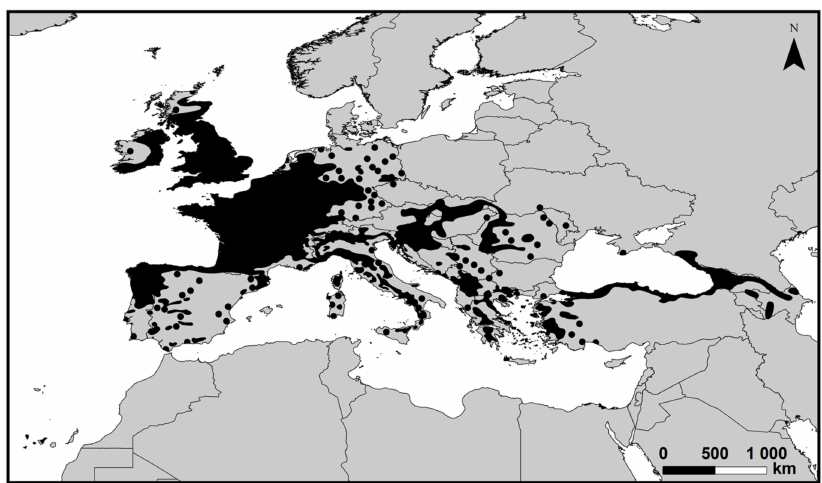
Figure 2. The distribution area of sweet chestnut ( Castanea sativa ) forests throughout Europe (2020), according to [16–18].